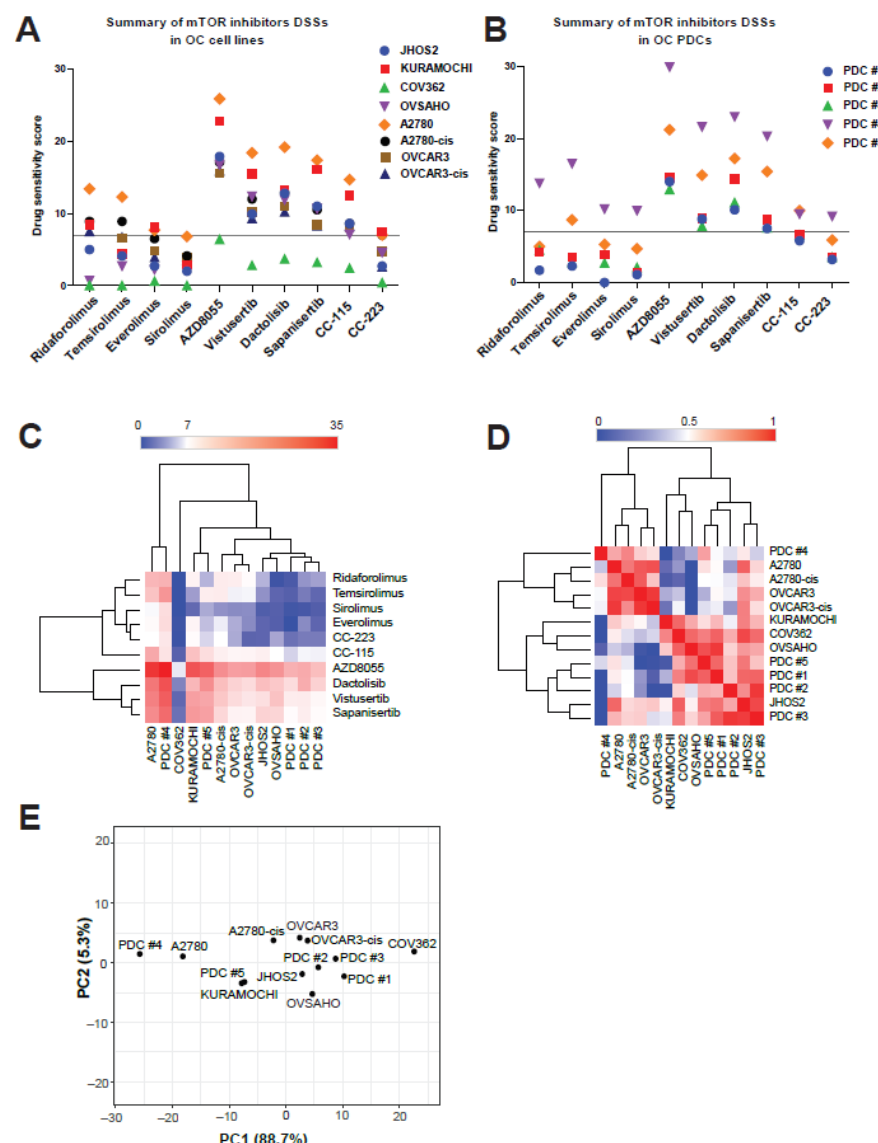
Figure 4. Evaluation of drug responses for mTOR inhibitors ( n = 10) in OC cell lines and PDCs. Comparison of DSS values for mTOR inhibitors in OC cell lines ( A ) and PDCs ( B ). An arbitrary threshold of DSS 7 was chosen to define a moderate drug cytotoxicity. Analysis of drug responses based on hierarchical clustering ( C ), similarity matrix ( D ) and PCA plot ( E ) of combined DSS values from OC cell lines and PDCs (from patients #1 to #5).